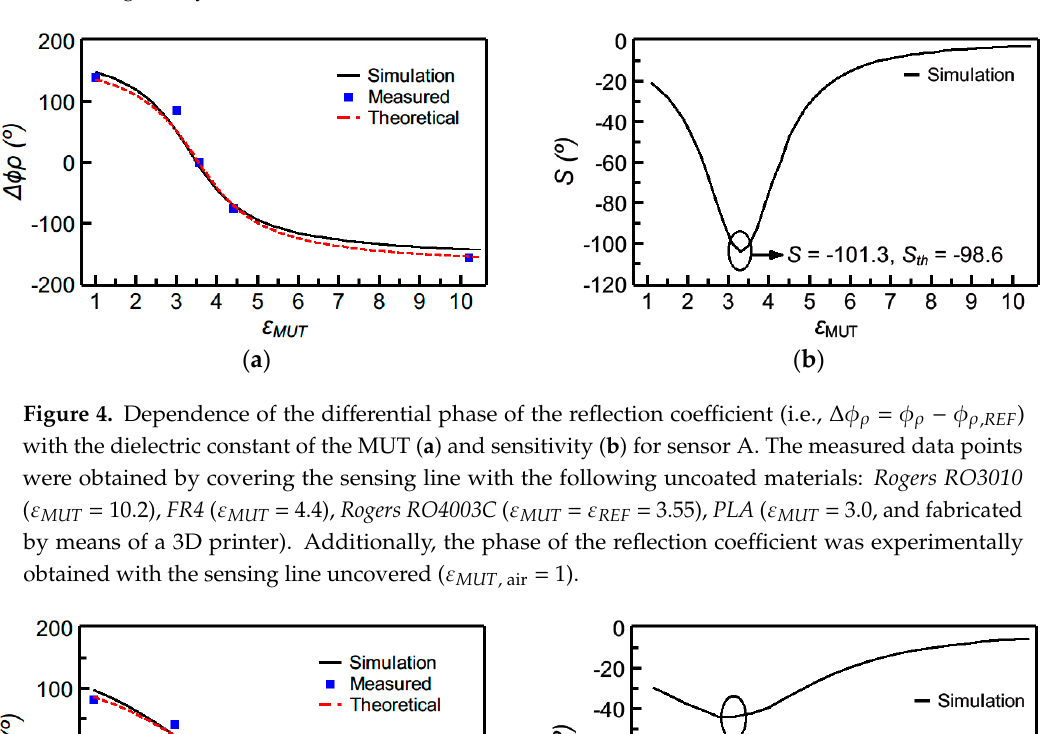
Figure 4. Dependence of the differential phase of the reflection coefficient (i.e., ∆ ϕ ρ = ϕ ρ − ϕ ρ , REF ) with the dielectric constant of the MUT ( a ) and sensitivity ( b ) for sensor A. The measured data points were obtained by covering the sensing line with the following uncoated materials: Rogers RO3010 ( ε MUT = 10.2), FR4 ( ε MUT = 4.4), Rogers RO4003C ( ε MUT = ε REF = 3.55), PLA ( ε MUT = 3.0, and fabricated by means of a 3D printer). Additionally, the phase of the reflection coefficient was experimentally obtained with the sensing line uncovered ( ε MUT , air = 1). Figure 5. Dependence of the differential phase of the reflection coefficient (i.e., ∆ ϕ ρ = ϕ ρ − ϕ ρ , REF ) with the dielectric constant of the MUT ( a ) and sensitivity ( b ) for sensor B. The MUTs are identical to those of Figure 4.